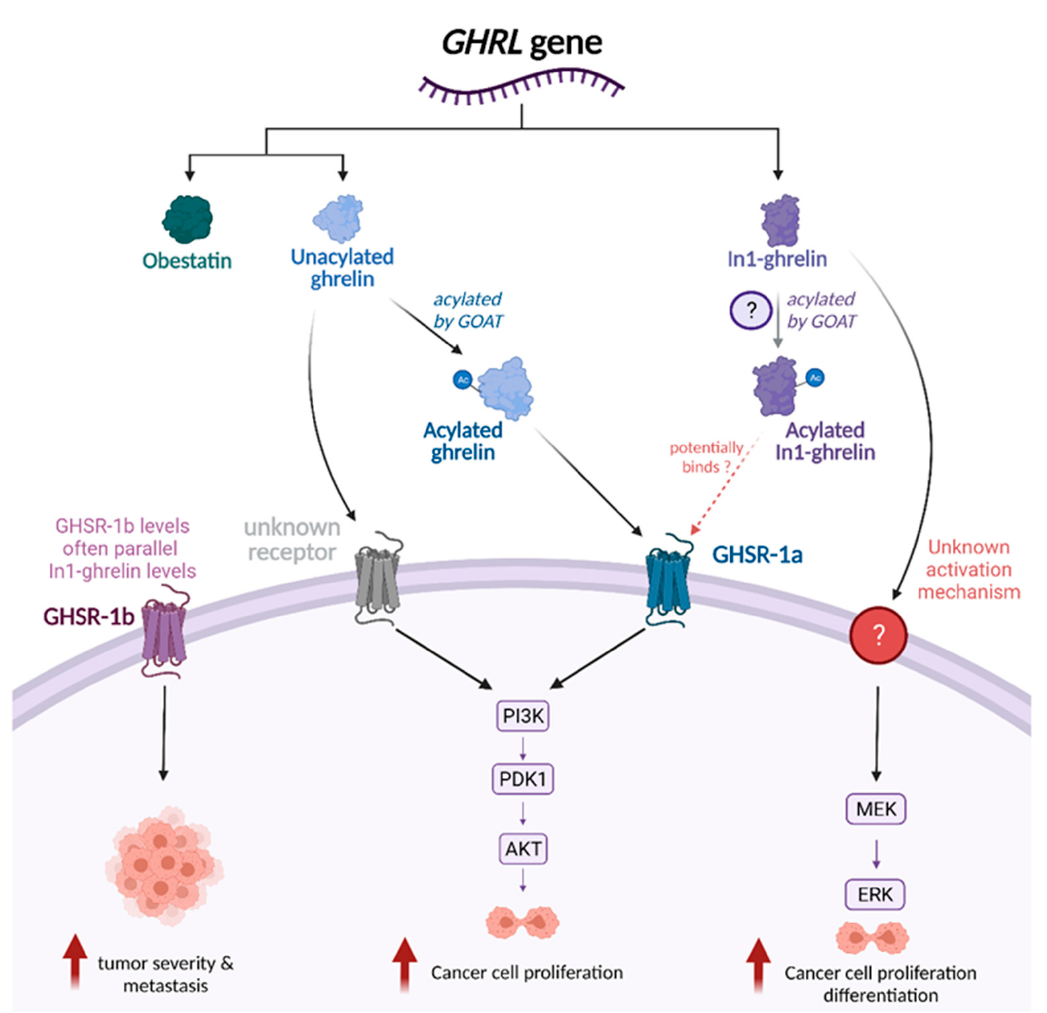
Figure 2. Proposed mechanistic links between ghrelin axis and tumor growth and metastasis. Pro- posed model illustrating pathways through which the ghrelin axis exerts proliferative effects on cancer cells. UAG and AG have both been found to activate the PI3K/Akt pathway and stimulate cancer cell proliferation in low doses, though AG acts in a GHSR-1a dependent manner while UAG’s